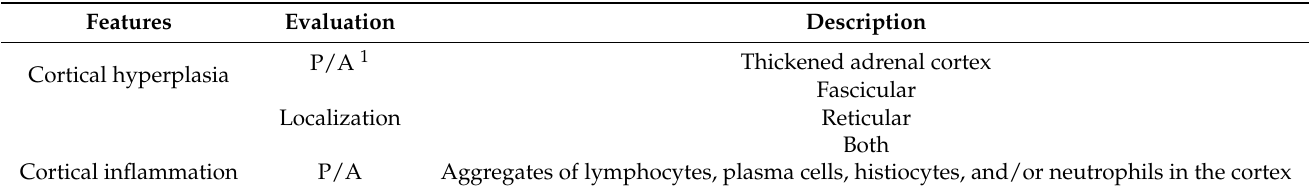
Table A9. Histopathological features evaluated in the adrenal gland.